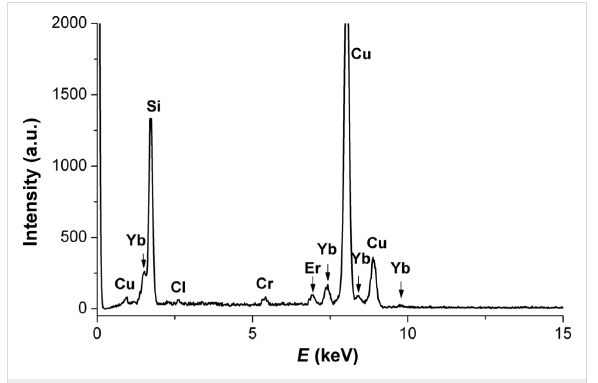
Figure 2: EDX spectra of the synthesized Er/Yb oxide particles with SiO 2 NPs.